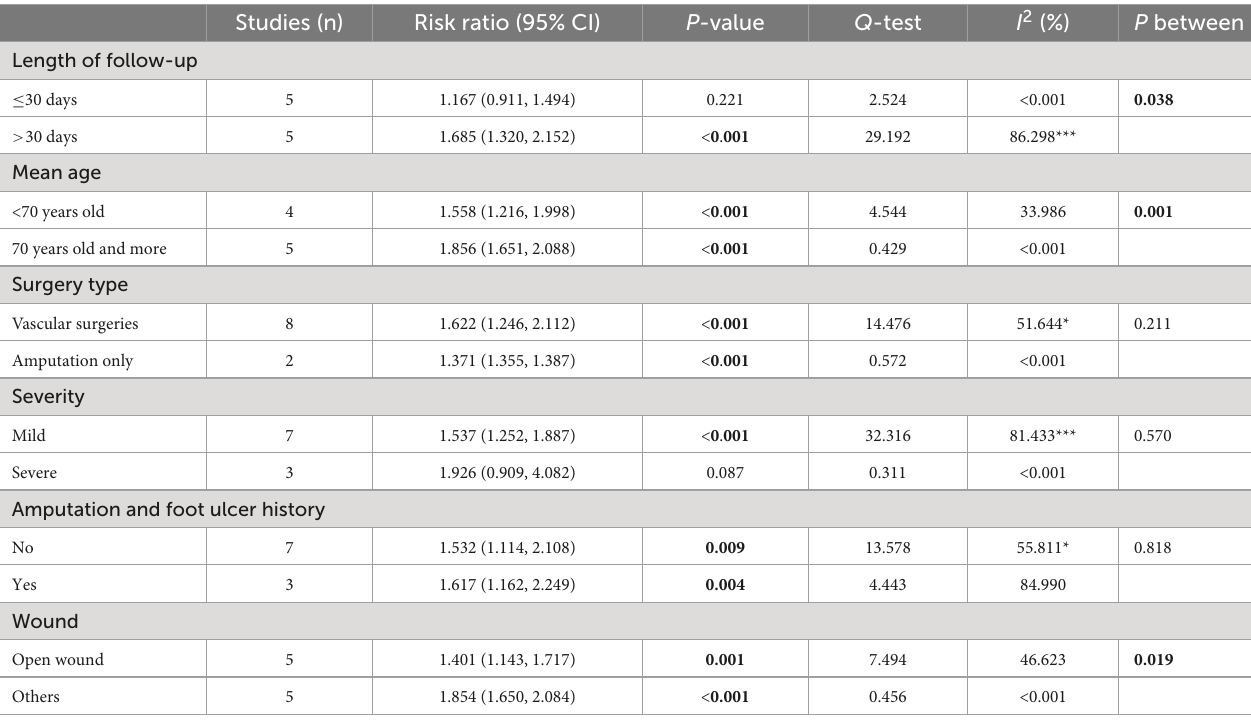
TABLE 6 Subgroup analysis on the association between frailty score and rehospitalisation rate.